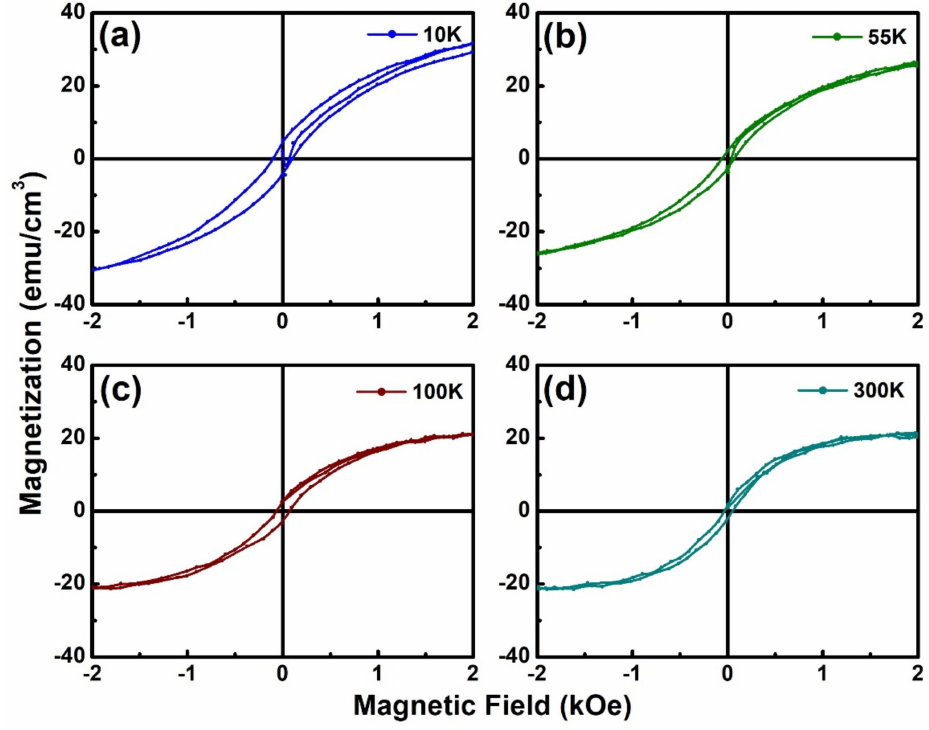
Figure 4. Magnetization vs. magnetic field of V 2 O 3 thin films measured at different temperatures ( a ) 10 K; ( b ) 55 K; ( c ) 100 K; ( d ) 300